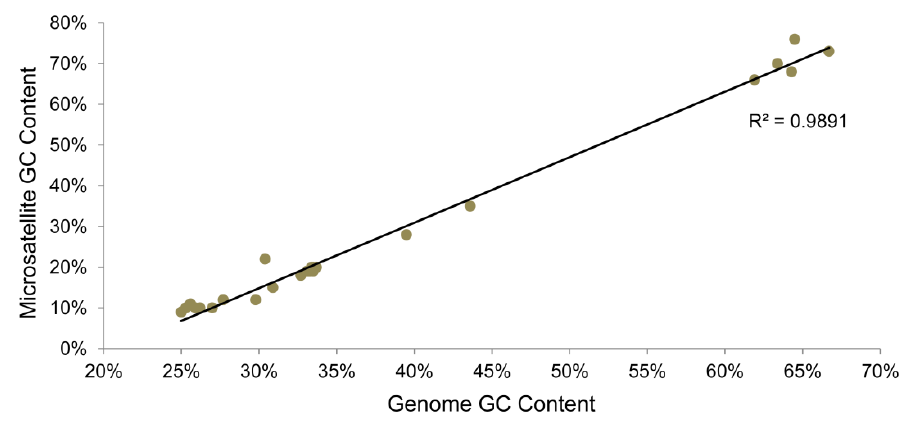
Figure 7. Correlation of microsatellite GC content and genome GC